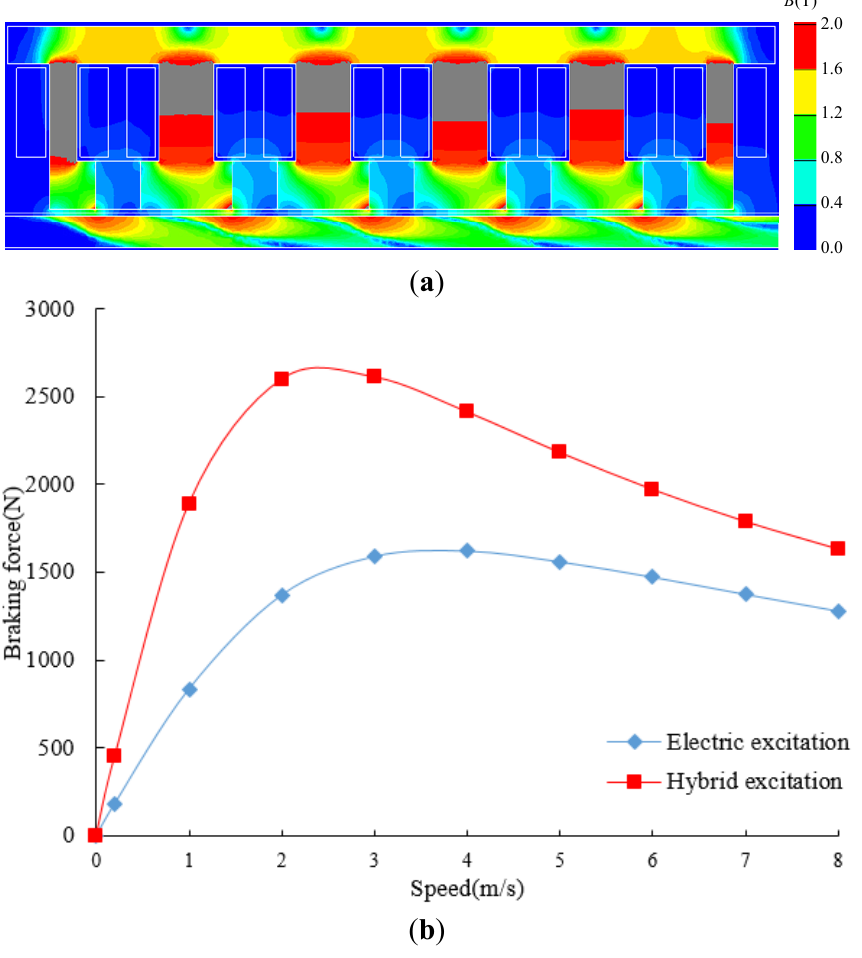
Figure 18. ( a ) Magnetic flux density map of the electric excitation eddy current brake and ( b ) a comparison between the electric excitation eddy current brake and hybrid excitation eddy current